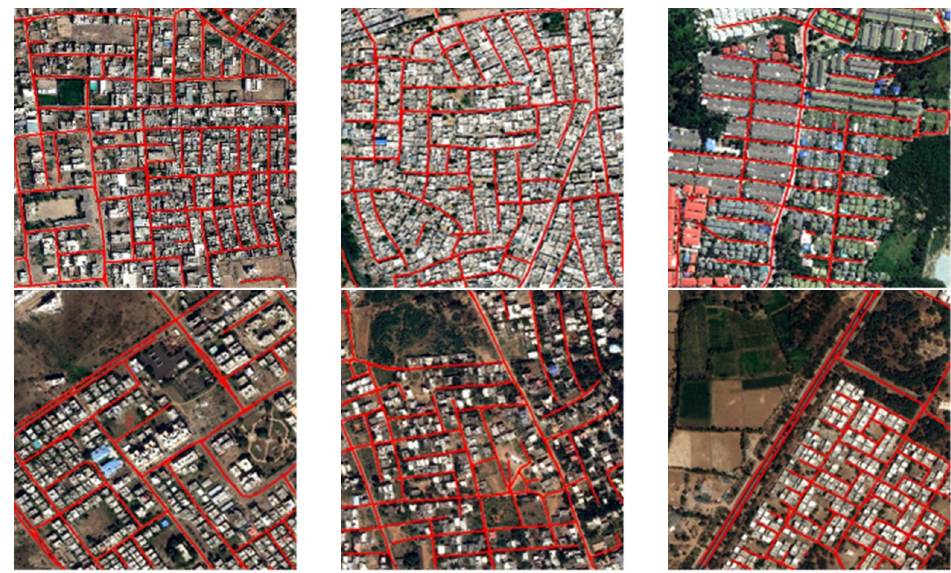
Figure 7. Visualization results of the proposed Bi-HRNet on DeepGlobe dataset.